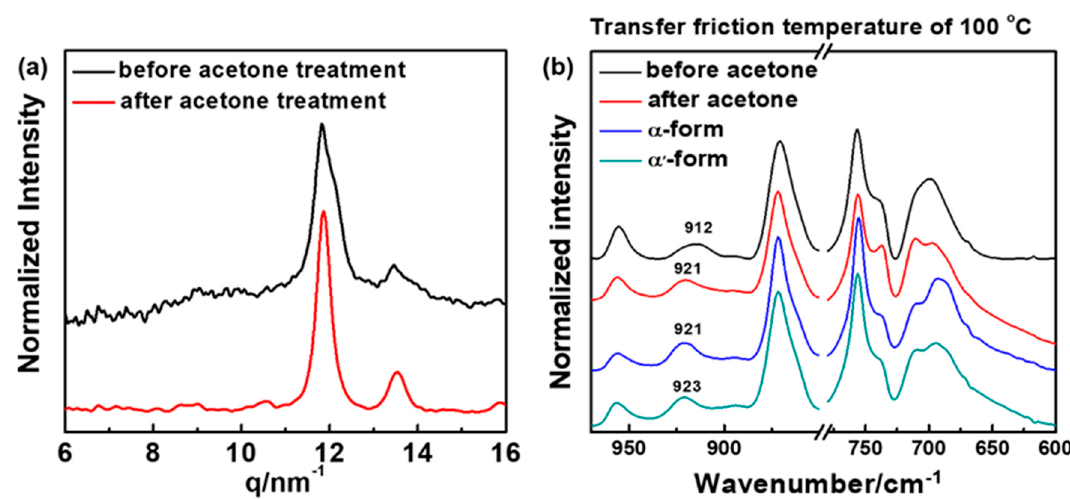
Figure 9. ( a ) 1D X-ray profiles and ( b ) FTIR spectra of oriented PLLA films friction transferred at 100 °C before and after acetone treatment for 24 h. For comparison, FTIR spectra of PLLA α -form annealing at 125 °C for 2 h and α′ -form annealing at 90 °C for 2 h in the region of 1000-600 cm − 1 are shown here.